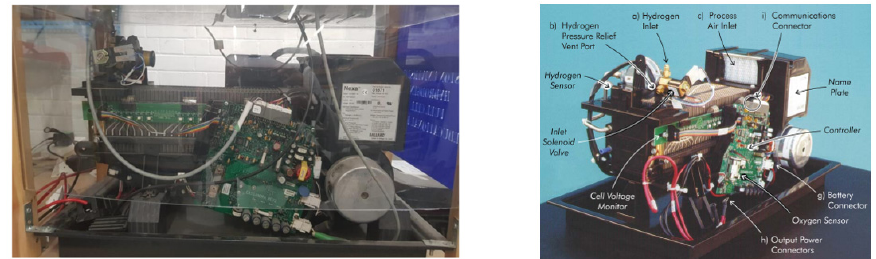
Figure 2. Diagram of the 1.2 kW Ballard fuel cell used for the investigation.